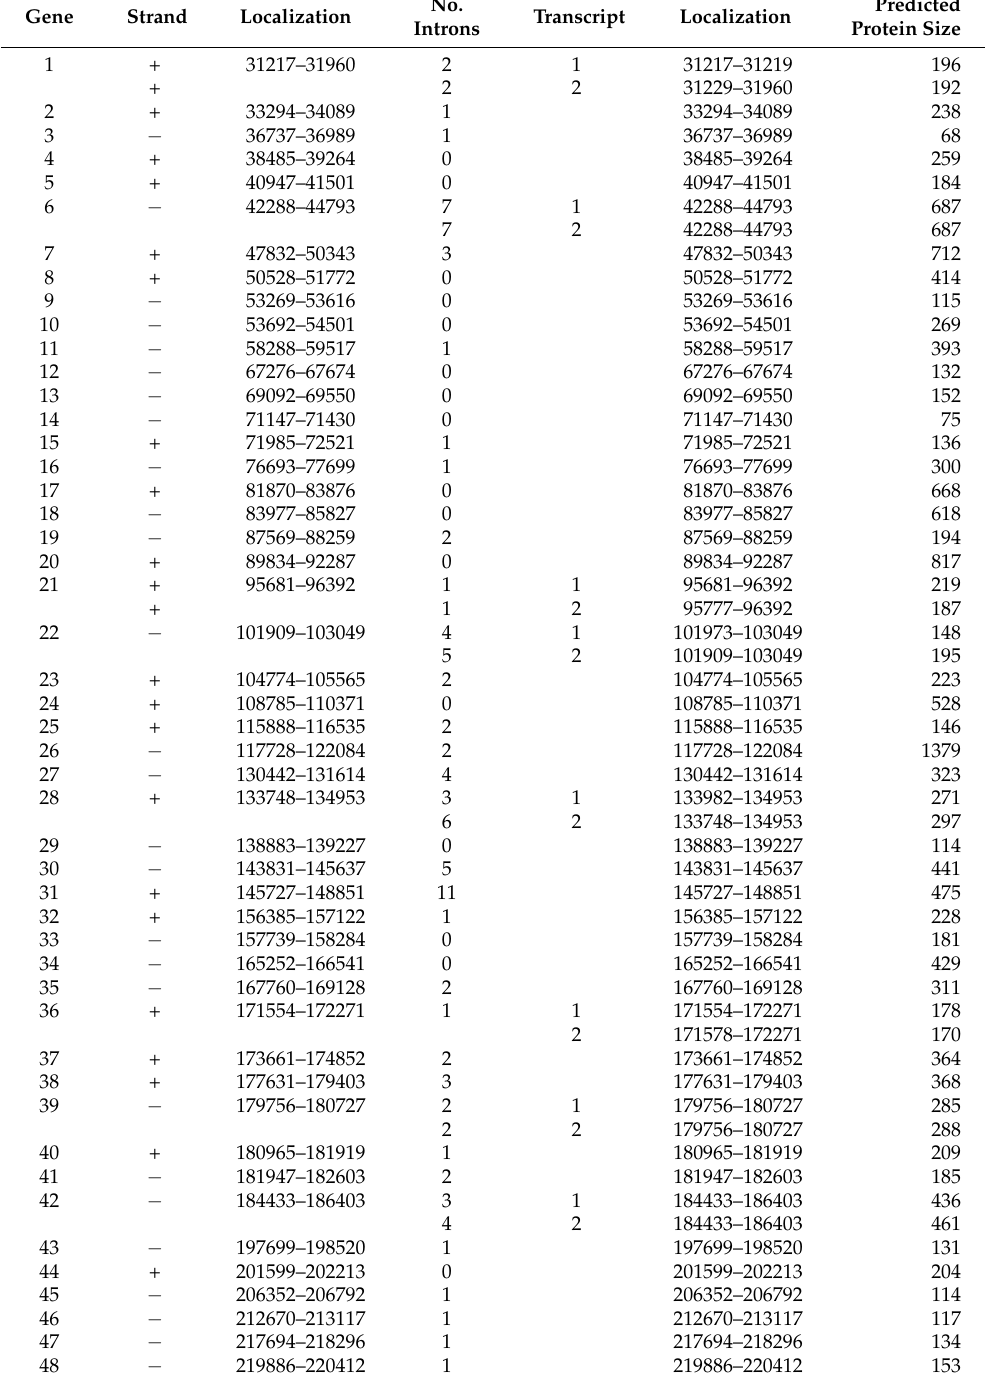
Table A1. Localization of putative Open Reading Frames and transcripts, protein sizes, and number of introns derived from the F. circinatum 12th chromosome